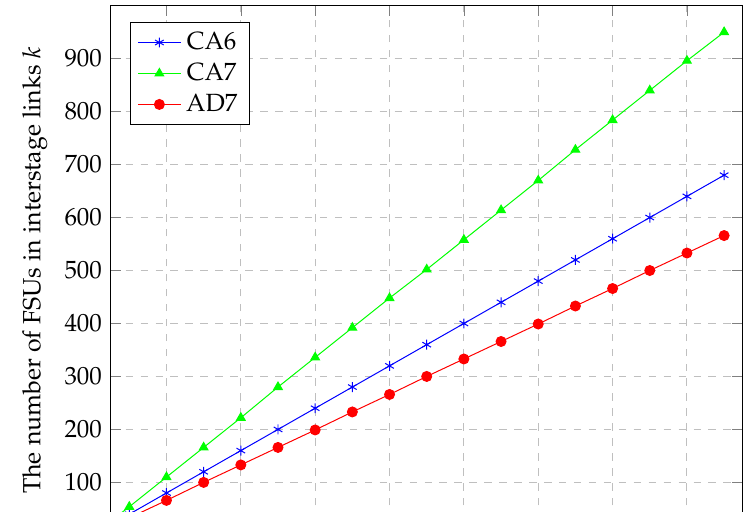
presented in [15] and required by Theorem RNB